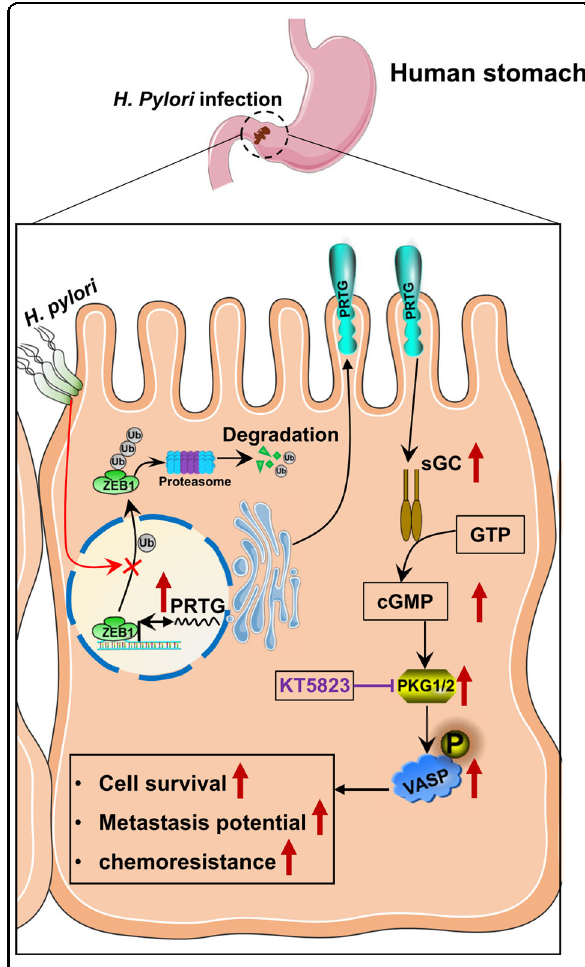
Fig. 7 Schematic diagram of the ZEB1/PRTG/cGMP/PKG regulatory mechanism in H. pylori -infected gastric cells. H. pylori promotes ZEB1 stabilization and recruitment to PRTG promoter, and which resulted the upregulation of PRTG expression. Then, PRTG activated the subsequent cGMP/PKG signaling pathway to perform oncogenic activities. PKG inhibitor KT5823 antagonizes the effect of PRTG-induced gastric cancer progression and enhance the effect of